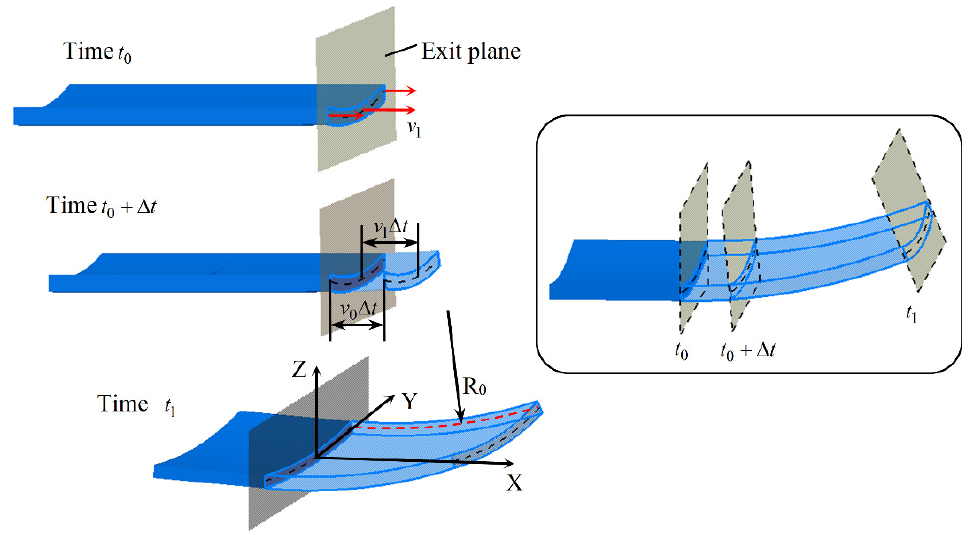
Figure 5. Process of ideal continuous roll forming.